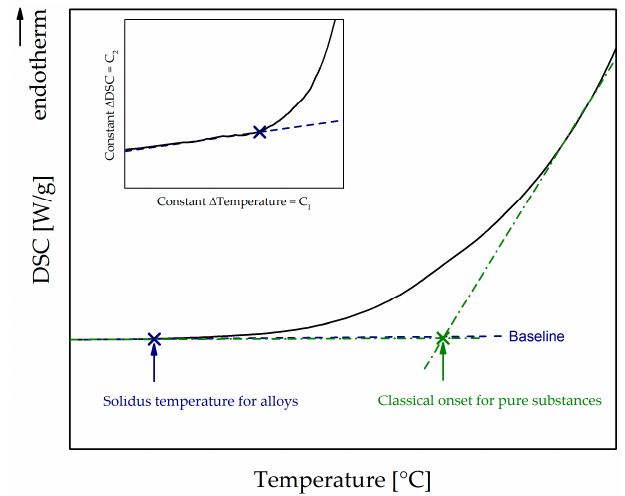
Figure 3. Comparison of a user-defined determination of solidus temperatures for alloys with large melting intervals with the classical onset technique for evaluation of the melting point of pure substances based on a DSC curve.